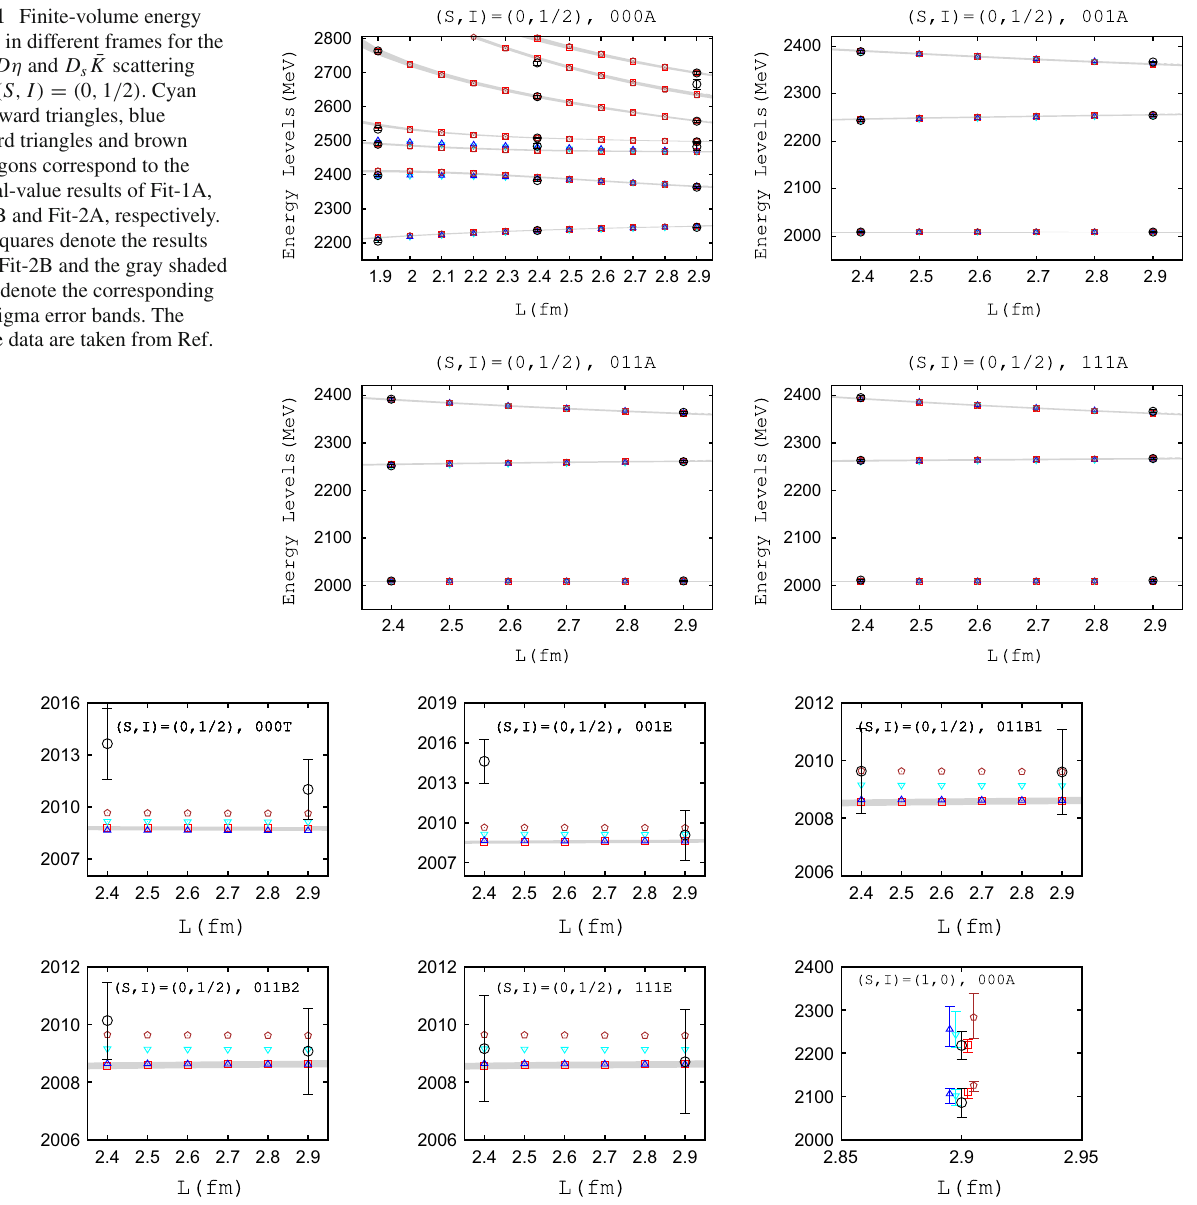
Fig. 2 Finite-volume energy levels of the P -wave D π scattering with ( S , I ) = ( 0 , 1 / 2 ) (the first five panels) and the energy levels of the elastic S -wave DK scattering with ( S , I ) = ( 1 , 0 ) (the last panel in the